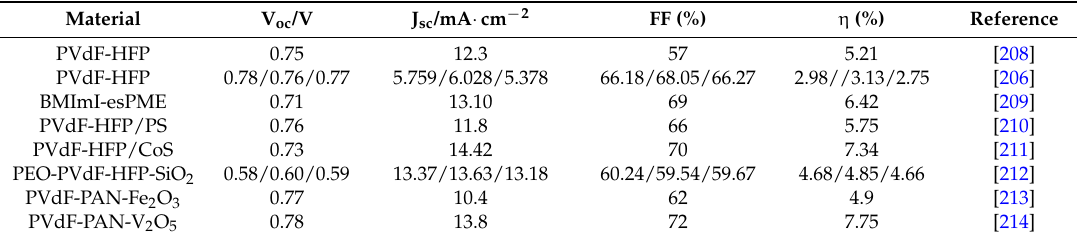
Table 5. Photovoltaic performance of the DSSCs based on electrospun